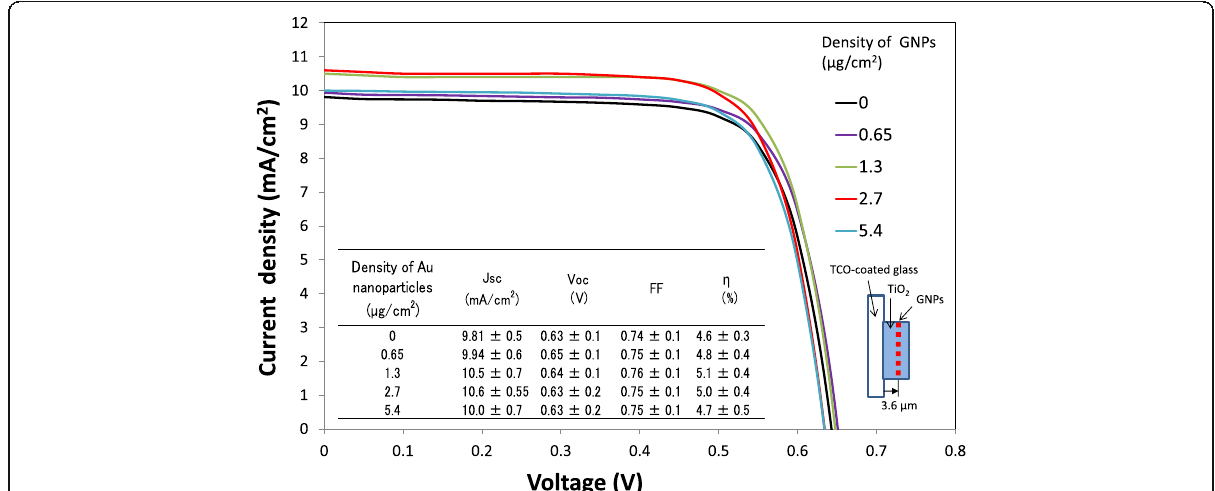
Fig. 4 Current density – voltage curves of the DSSCs with changing the density of GNPs per GNP layer. Four cells for each density of GNPs were fabricated. The GNP layer is formed in a TiO 2 layer of 6.0 μ m thickness at the position of 3.6 μ m from the TCO